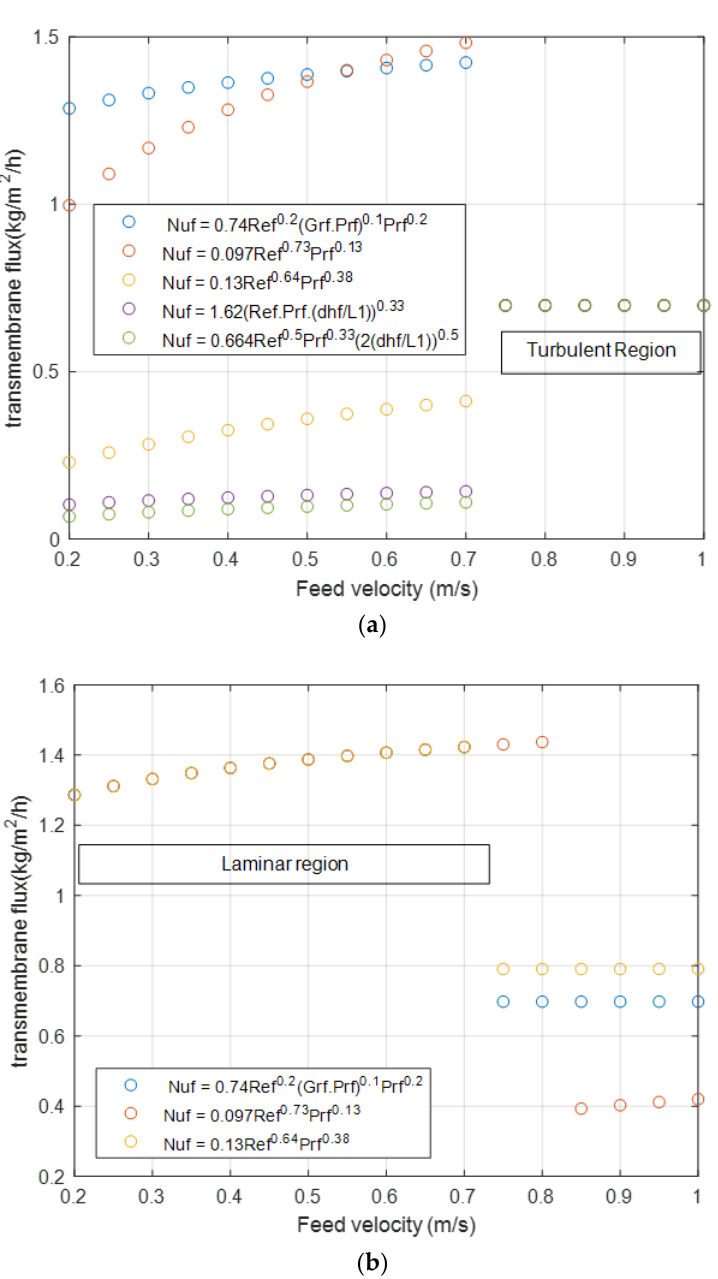
Figure 9. Transmembrane flux versus velocity for heat transfer coefficient correlations in the ( a ) laminar region and the ( b ) turbulent region.